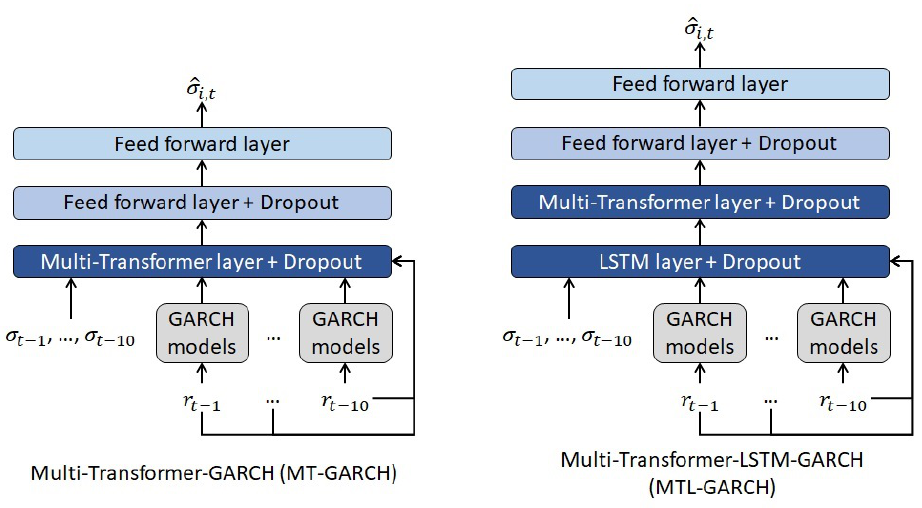
Figure 6. MT-GARCH and MTL-GARCH volatility